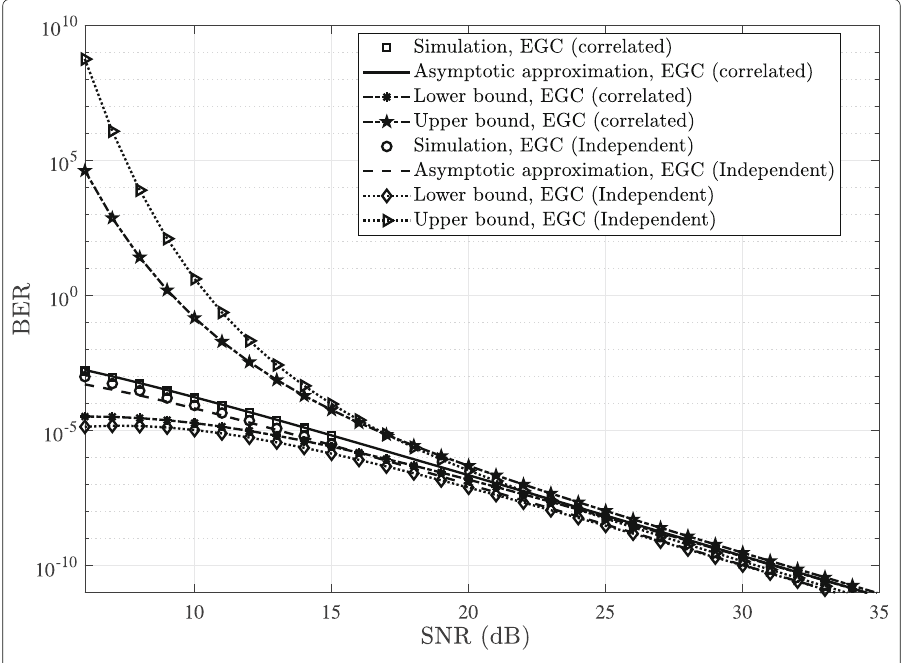
Fig. 9 BER curves for the asymptotic approximation, lower bound, and upper bound for EGC, over correlated and independent BX fading channels. The number of branches is N = 2, the fading parameter is m = 1.5, and (cid:12) C 1 , 0 2 × 2 , 0 2 × 2 ; 0 2 × 2 , C 2 , 0 2 × 2 ; 0 2 × 2 , 0 2 × 2 , C 3 the correlation structures is C b = C 1 = C 2 = C 3